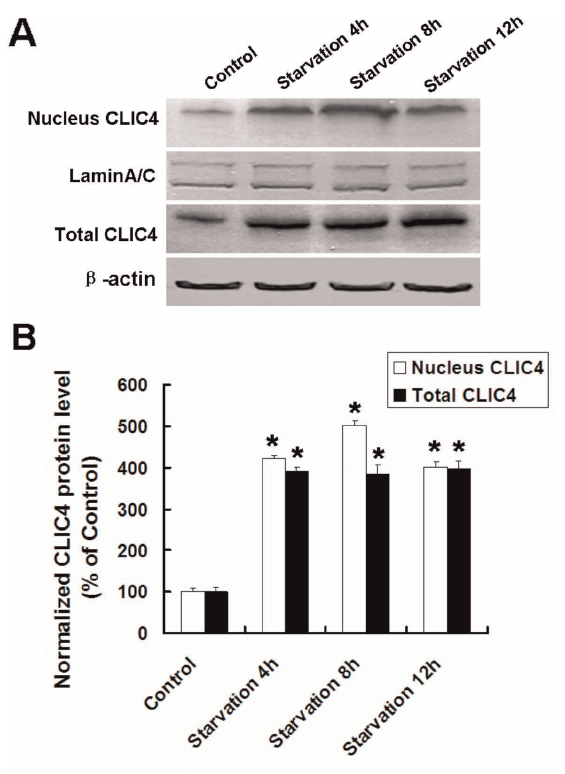
Figure 2. Starvation does not induce apoptosis in human U251 cells. (A) Western blot analysis of Procaspase-3 and Cleaved caspase-3 expression in U251 cells incubated with EBSS for 4 h, 8 h and 12 h. (B) Flow cytometric analysis of apoptosis in U251 cells incubated with EBSS for 4 h, 8 h and 12 h. Cells were stained with PI and Annexin V-FITC. The positive stained cells were counted using FACScan. Data were presented as mean, n=3.